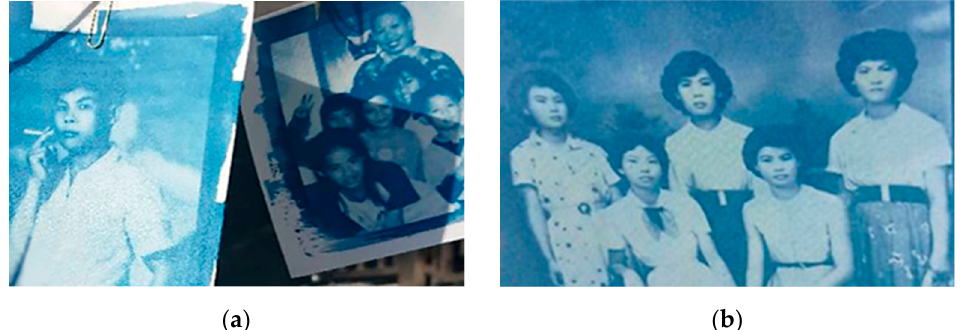
Figure 2. Creations from the Stage 2 IEC workshops. ( a ) Cyanotype under the theme “Tribute to the youthful years” (E2-C-Week12). Photographs of an elder when he was a youth were transformed into cyanotypes, which triggered smiles while recalling the brilliance of life. ( b ) Cyanotype under the theme “Tribute to the youthful years” (E6-C-Week12). A photograph of an elder when she was a youth was transformed into a cyanotype that showcases the luminance and vitality of life.